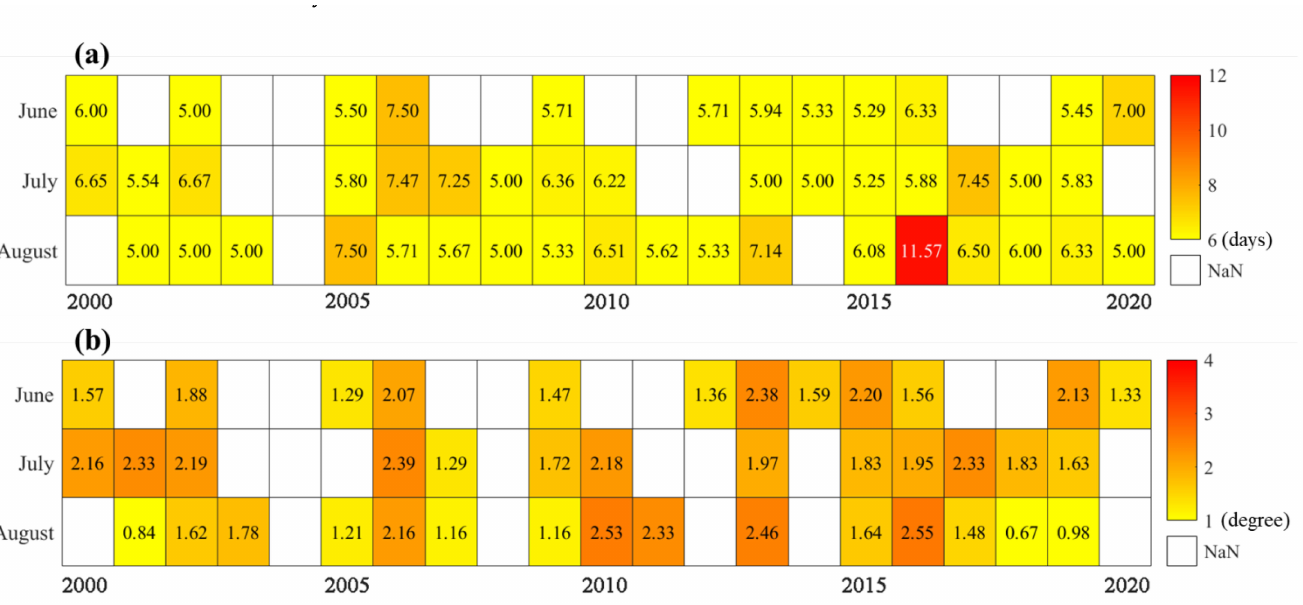
Figure 3. Matrix heatmap for heatwave duration and intensity in June, July, and August on the Tibetan Plateau from 2000 to 2020. The matrix heatmap ( a ) refers to the temporal change of the heatwave duration; the matrix heatmap ( b ) refers to the temporal change of the heatwave intensity. Each grid cell represents the average duration and intensity of a heatwave at all sites in a given month of a year. The blank grid cell represents no heatwave, and the value is NaN. The color of the matrix heatmap represents the size of the value.